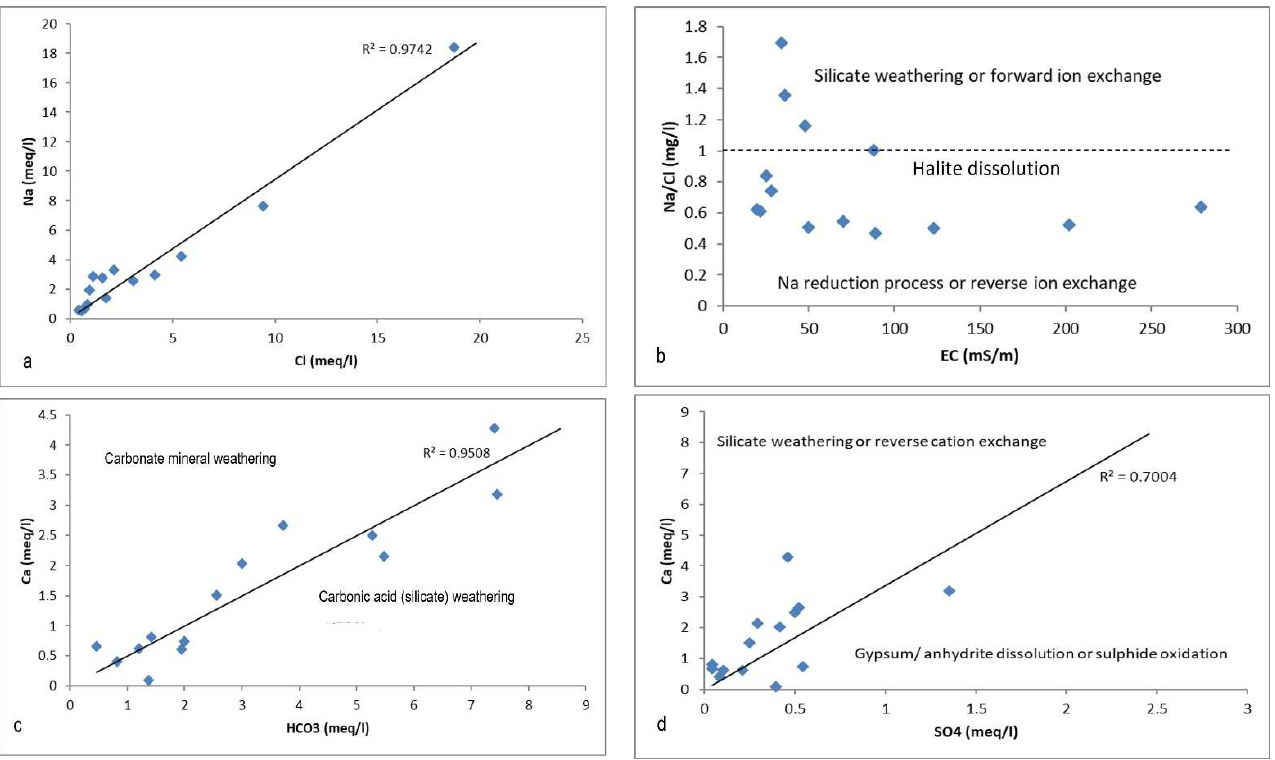
Figure 5. Scatter plots for ( a ) Na + vs. Cl − ; ( b ) Na + /Cl − vs. EC; ( c ) Ca 2+ vs. HCO 3− ; ( d ) Ca 2+ vs. SO 4− of water collected in the Soutpansberg region.